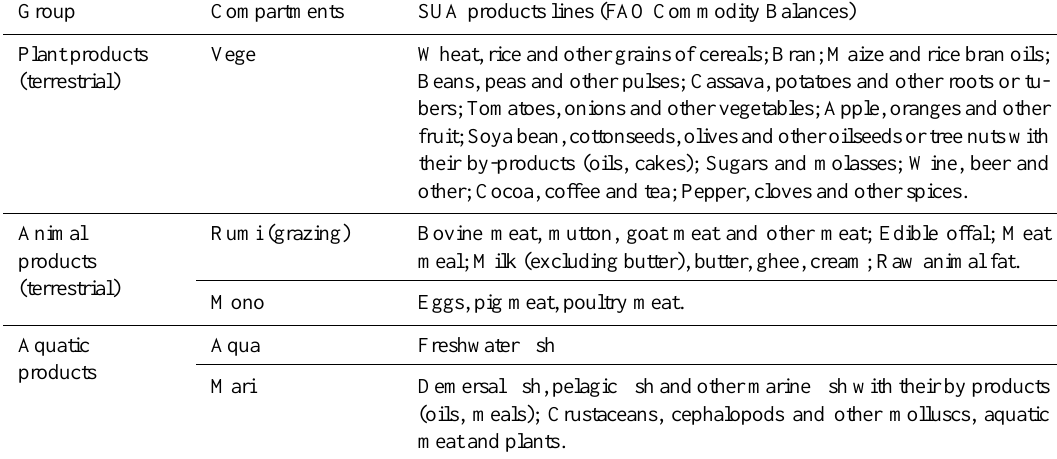
Table 7. Compartmentalisation of food biomasses in